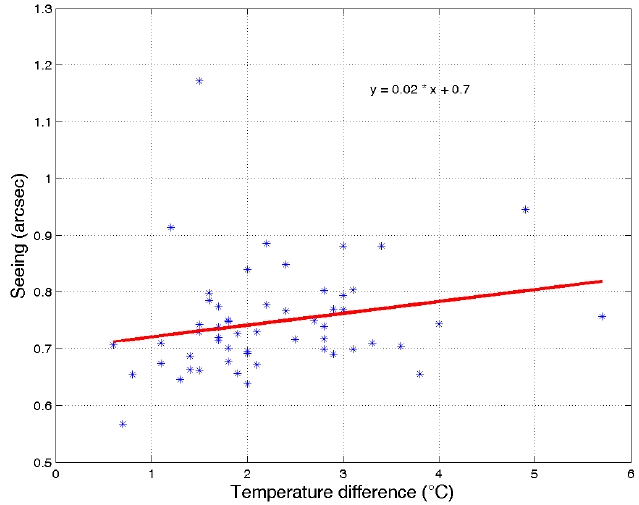
Table 3. Correlation coefficient for seeing and meteorological parameters.